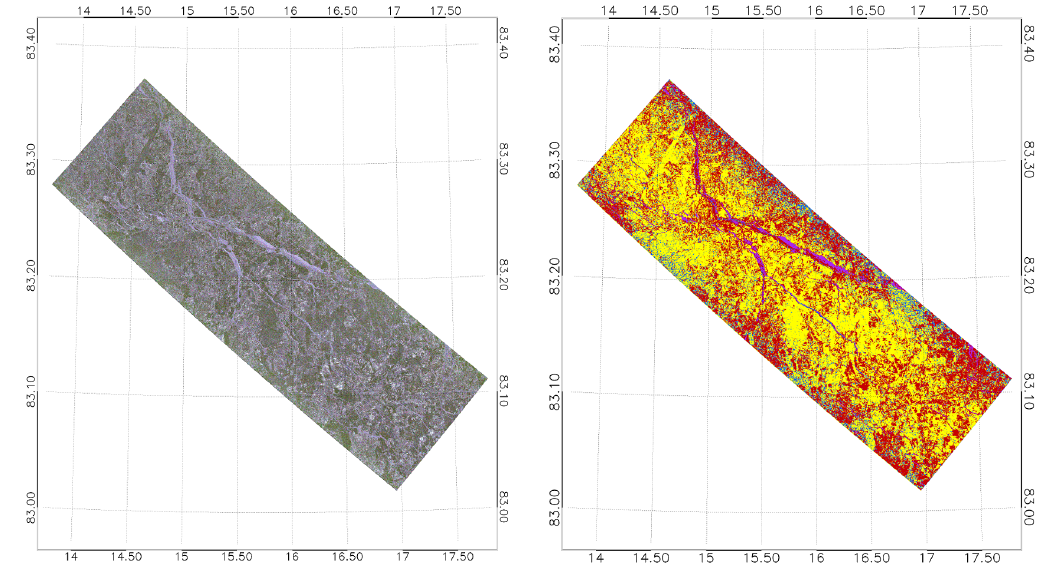
Figure A6. ( Left ) Geocoded Pauli RGB composite (Red: HH-VV Green: HV+VH Blue: HH+VV) of the TS-X acquisition on 23 April 2015, frame 1; ( Right ) ice classification. Blue: open water/nilas (OW), purple: young ice (YI), yellow: first year ice (SFYI), red: rough first year ice/multi-year ice (RFYMYI).